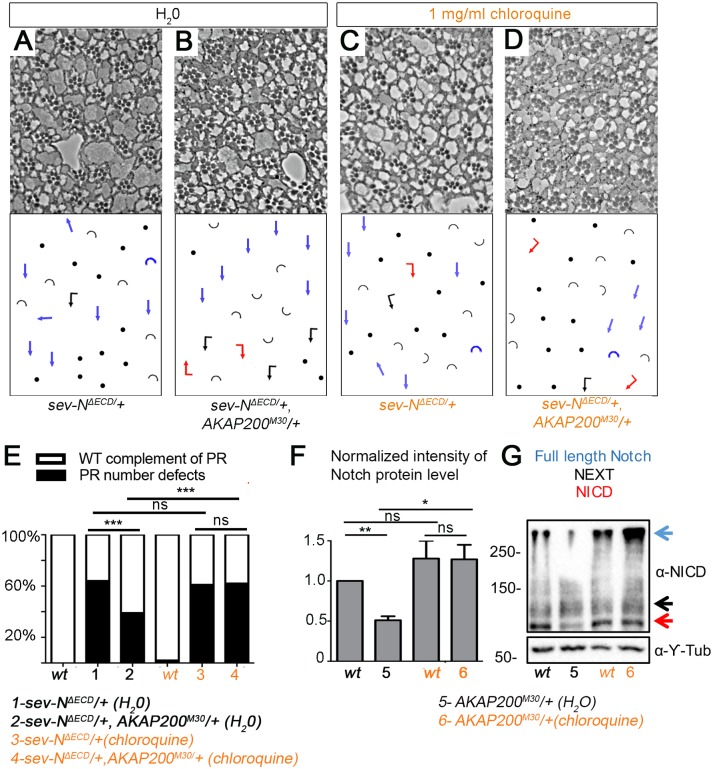
AKAP200 effect on Notch depends on lysosomal degradation.(A-D) Tangential adult eye sections of indicated genotypes and conditions, and (E) quantification of indicated genotypes/conditions; suppression of PR number defects of sev-NΔECD/+ by AKAP200 is lost in the presence of 1mg/ml of lysosomal inhibitor, chloroquine (***p<0.0001 from chi square tests, n = 378–644 from 3–4 independent eyes). (F) Quantification (**p = 0.005, *p = 0.02, n = 4) and (G) western blot of third instar larval eye discs showing Notch protein levels in indicated genotypes. Relative to WT, heterozygous AKAP200 mutant decreases Notch levels (under control condition, H20 treatment), this effect is lost in the presence of 1 mg/ml chloroquine (Y-Tub, bottom, serves as loading control).